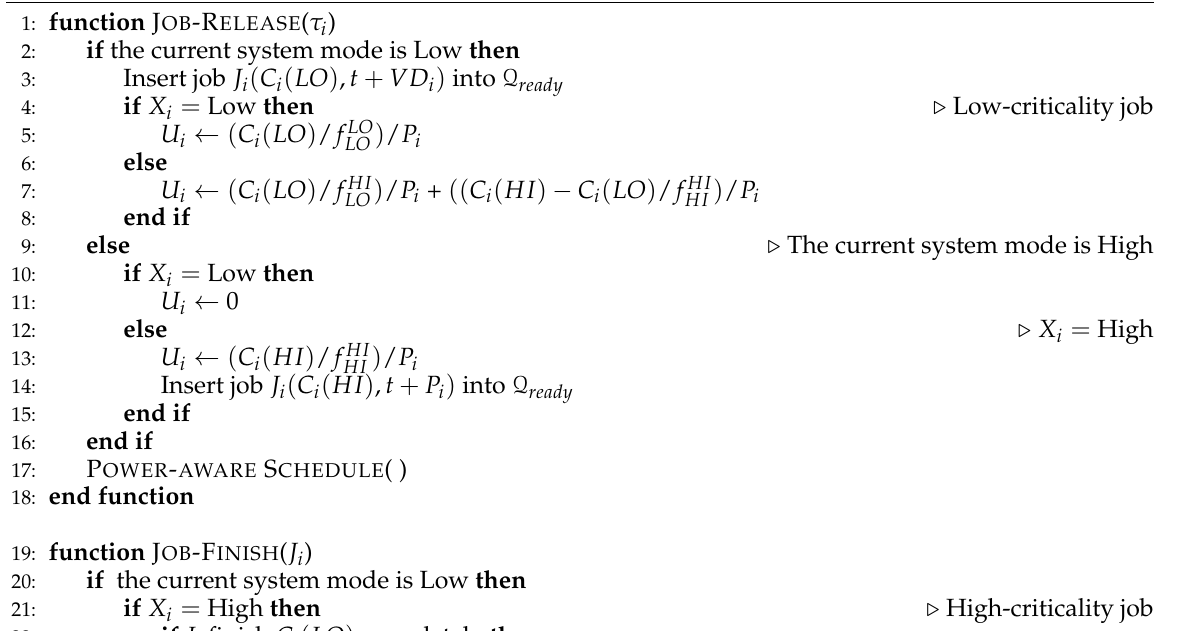
Algorithm 1 Algorithm of energy minimization consumption in mixed-criticality